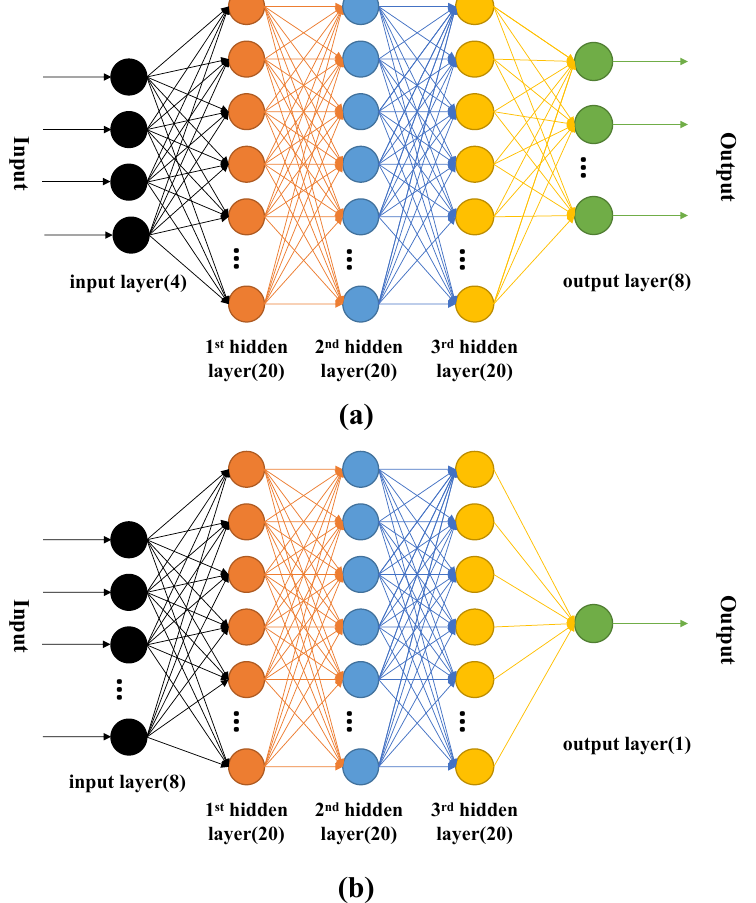
Figure 3. The structure of the generator and the discriminator network models. The number in parentheses after the layer name is the number of neurons contained in the layer. ( a ) Structure of the generator, ( b ) Structure of the